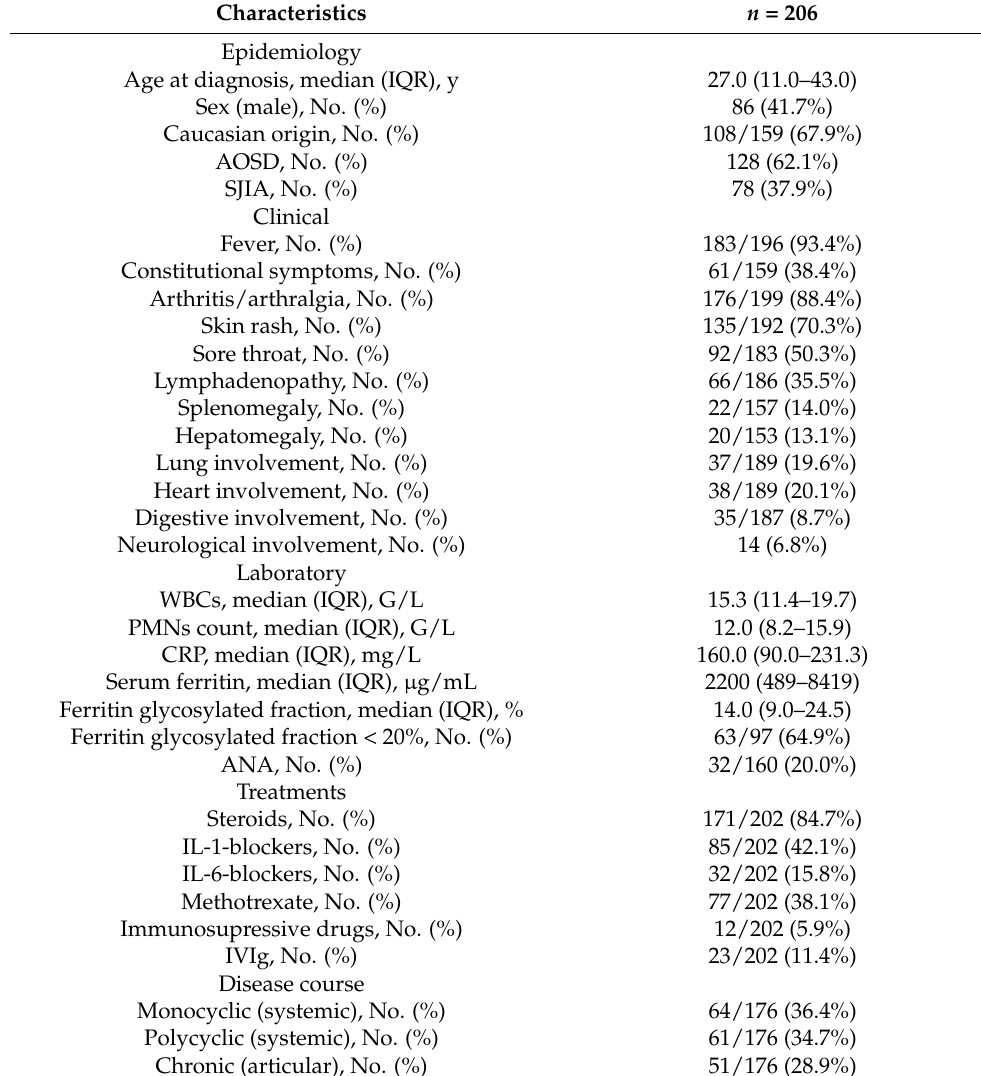
Table 1. Patient characteristics at the time of diagnosis of Still’s